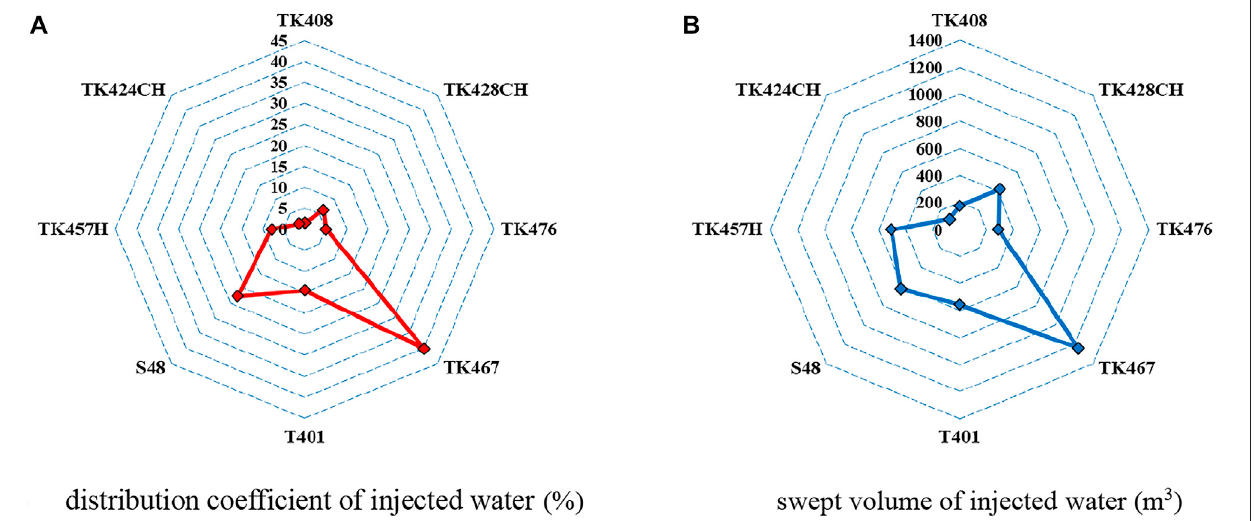
FIGURE18| Thedistribution coef fi cientandsweptvolumeofinjectedwaterofTK411wellgroup. (A) distributioncoef fi cientofinjectedwater(%) (B) sweptvolume of injected water (m 3 ).